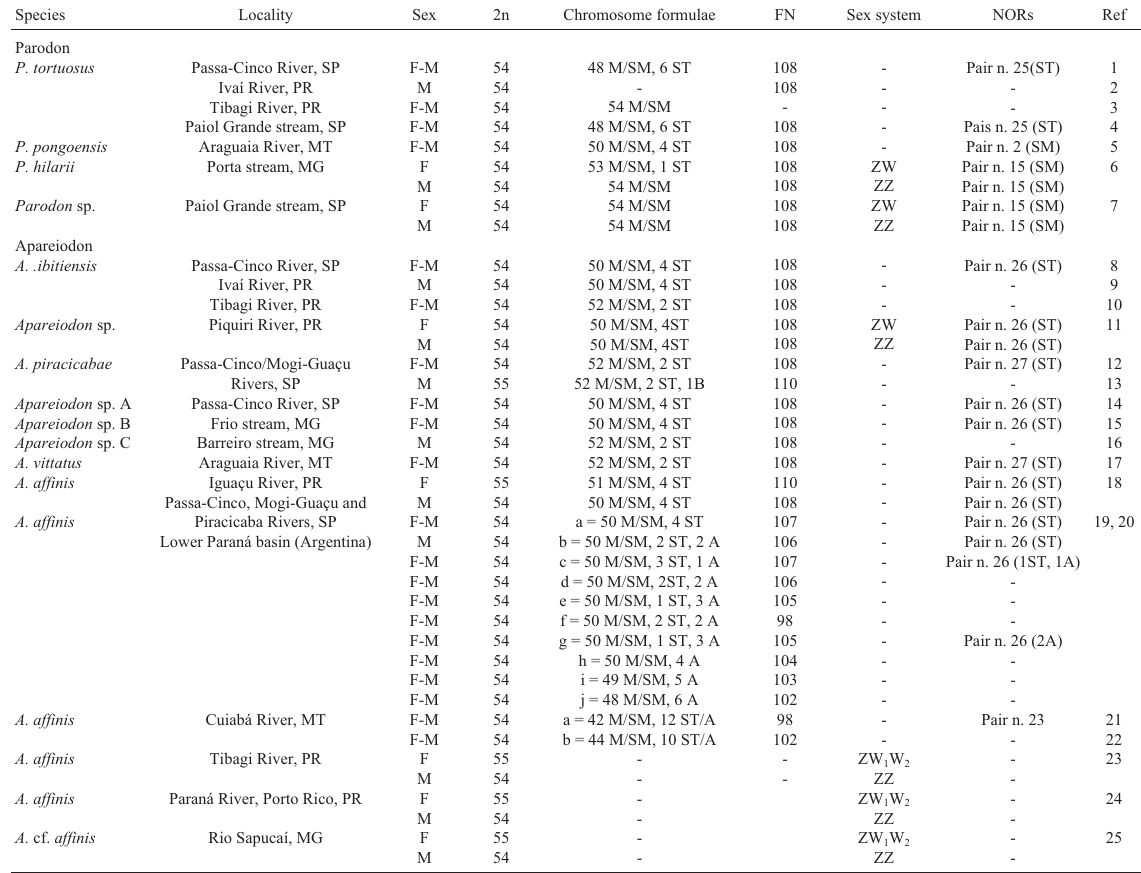
Table 1 - An overview of karyotypical data in Parodontidae species. Species Locality Sex 2n Chromosome formulae FN Sex